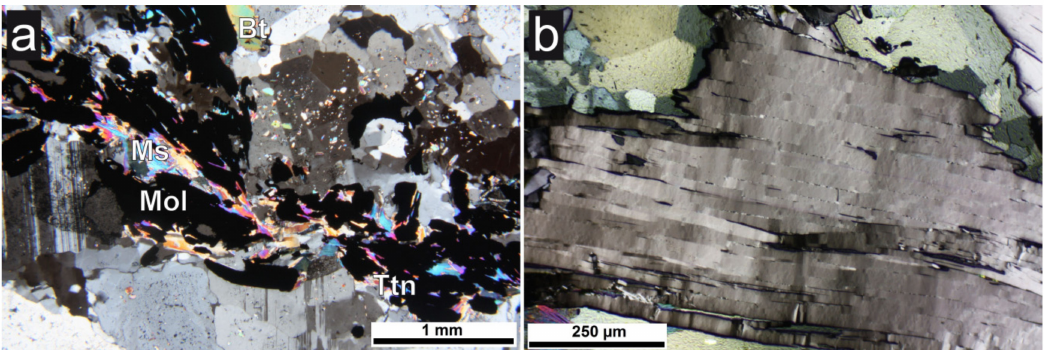
Figure 5. Photomicrographs of sample E in thin section. ( a ) Opaque molybdenite (Mol) with muscovite (Ms) and biotite (Bt) in quartz and feldspars. Transmitted light, crossed polarizers. ( b ) Molybdenite with perfect cleavage showing evidence of deformation expressed as undulose extinction. Reflected light, crossed